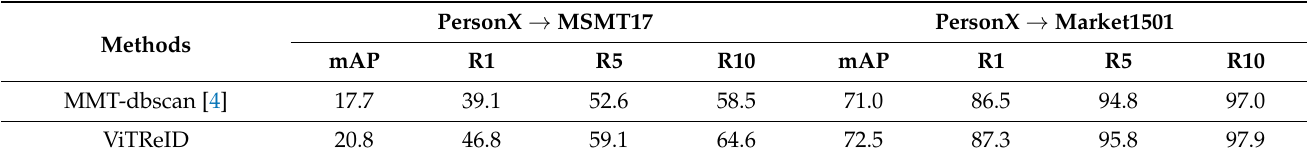
Table 3. Experimental results of PersonX synthetic dataset to pedestrian real dataset.